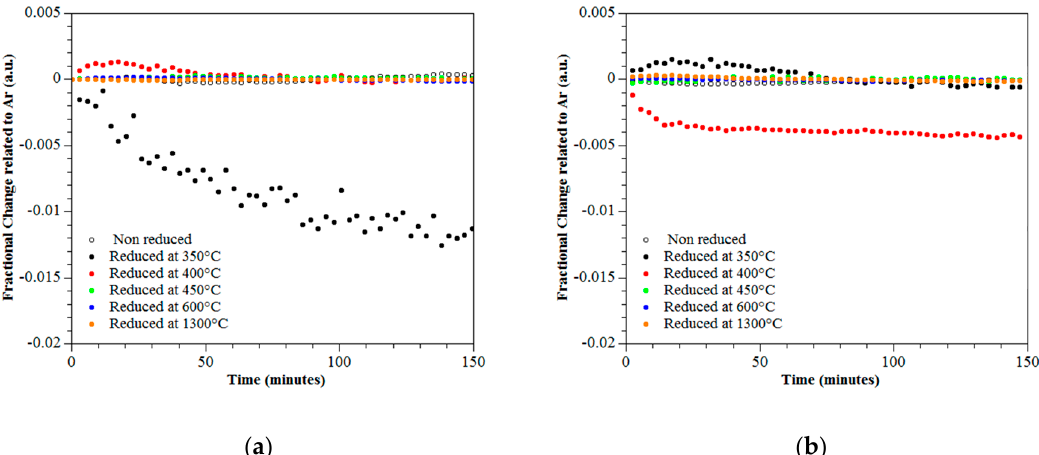
Figure 7. Fractional change of CO 2 over 150 min under UV of wavelengths ( a ) 376–387 nm and ( b ) 381–392 nm.